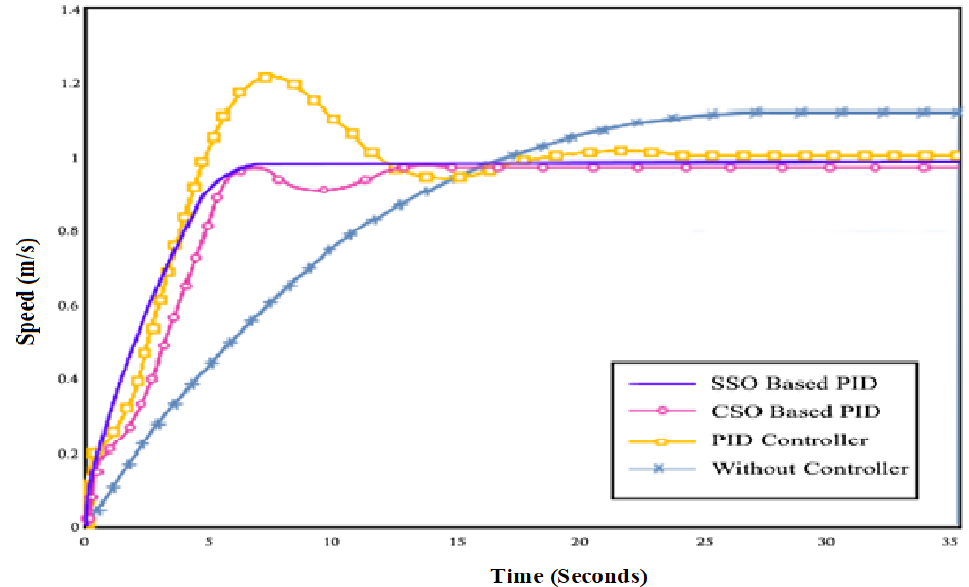
Figure 7. Comparison of closed-loop response of DC motor 1 in SSO, CSO, PID controller, and without controller.